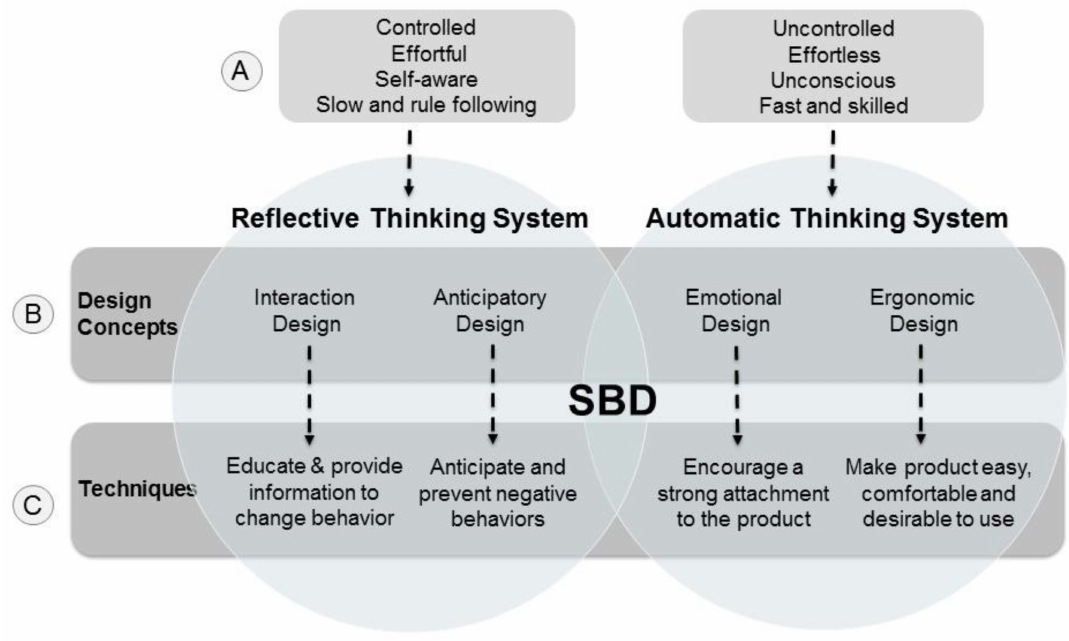
Figure 2. The SBD framework incorporates ( A ) traits associated with how people think (reflective and automatic), ( B ) appropriate design concepts, and ( C ) product-specific design